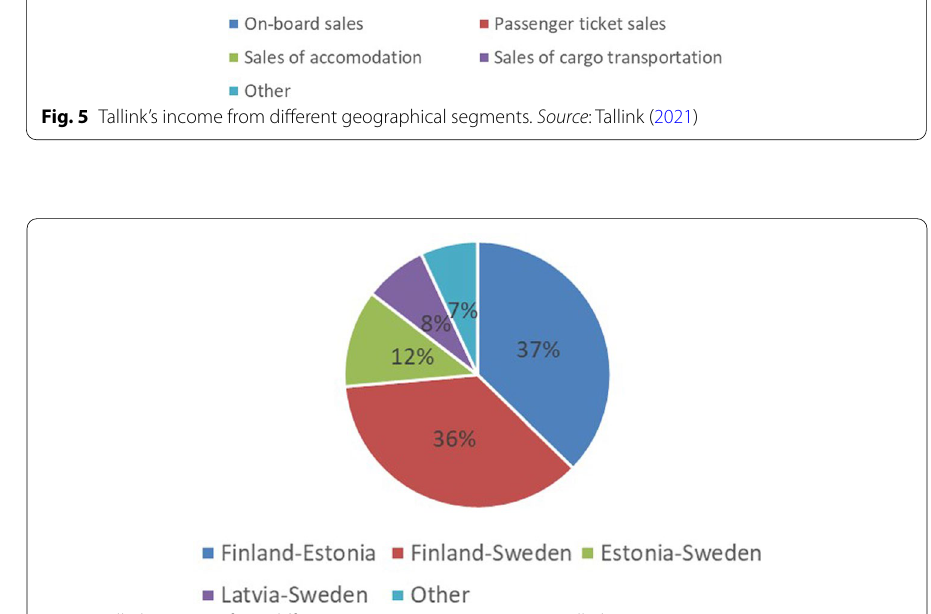
Fig. 6 Tallink’s income from diffrent operating segments. Source : Tallink